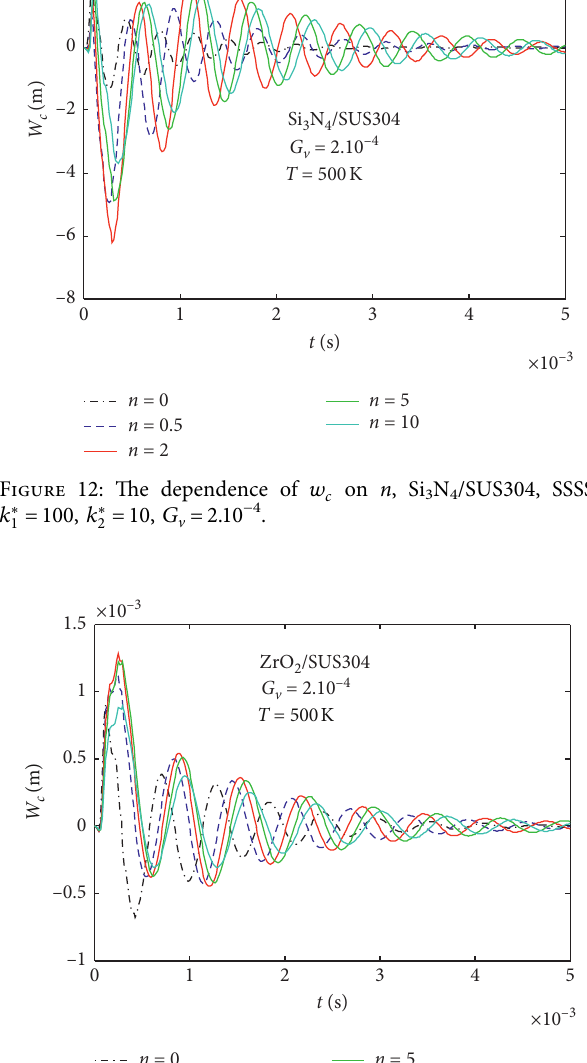
Figure 13: The dependence of w � 100, k ∗ � 10, G � 2.10 − 4 . k ∗ v 1 2